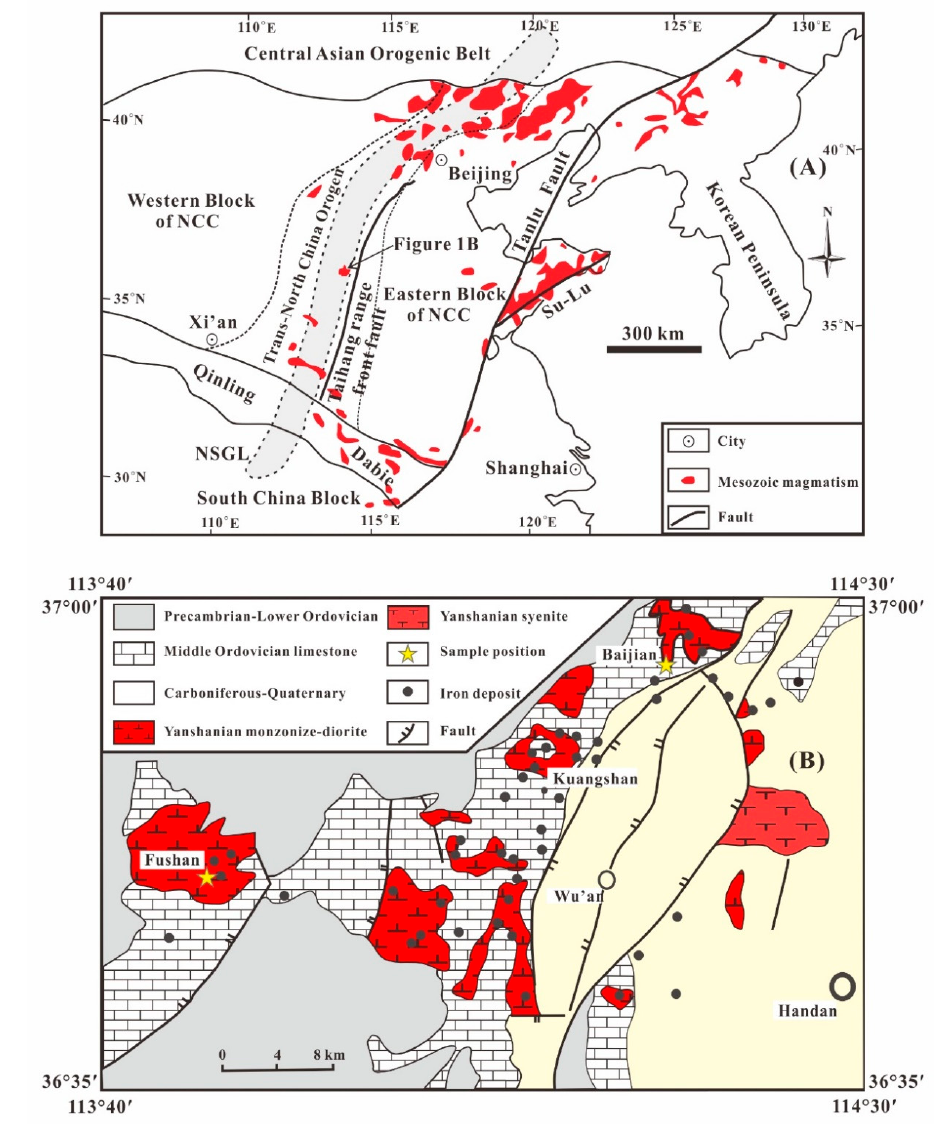
Figure 1. ( A ) Simplified geological map showing major tectonic subdivisions of the North China Craton (NCC) with emphasis on the distribution of Mesozoic magmatic rocks (after the references [22,23]). ( B ) Local geological map of the Han-Xing Fe skarn deposit (modified from the reference